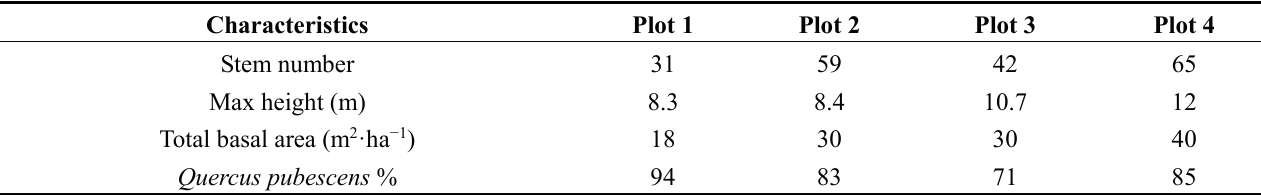
Table 1. Plot main